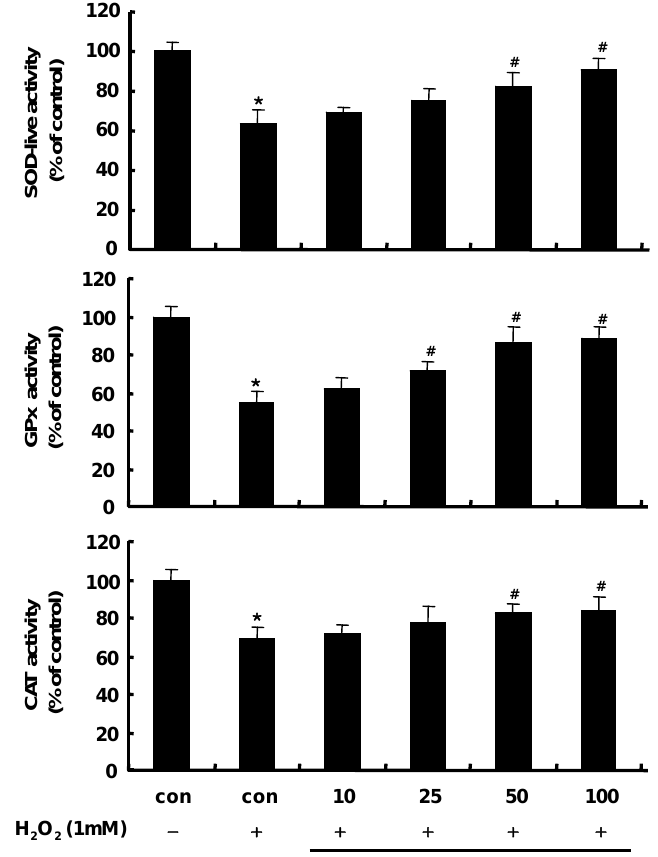
Figure 2. Effects of REO on superoxide dismutase (SOD)-like, glutathione peroxidase (GPx) and catalase (CAT) activities in H O -treated HepG2 cells. Data are mean ± SD 2 2 values of three individual experiments. The values were compared with the control using analysis of variance followed by unpaired student’s t tests. * p < 0.05, significant differences from the unstimulated control group. # p < 0.05, significant differences from O -treated the H 2 2